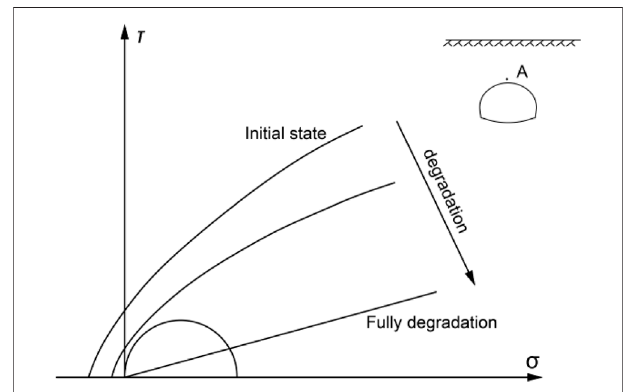
FIGURE 1 | Stressed mechanisms under